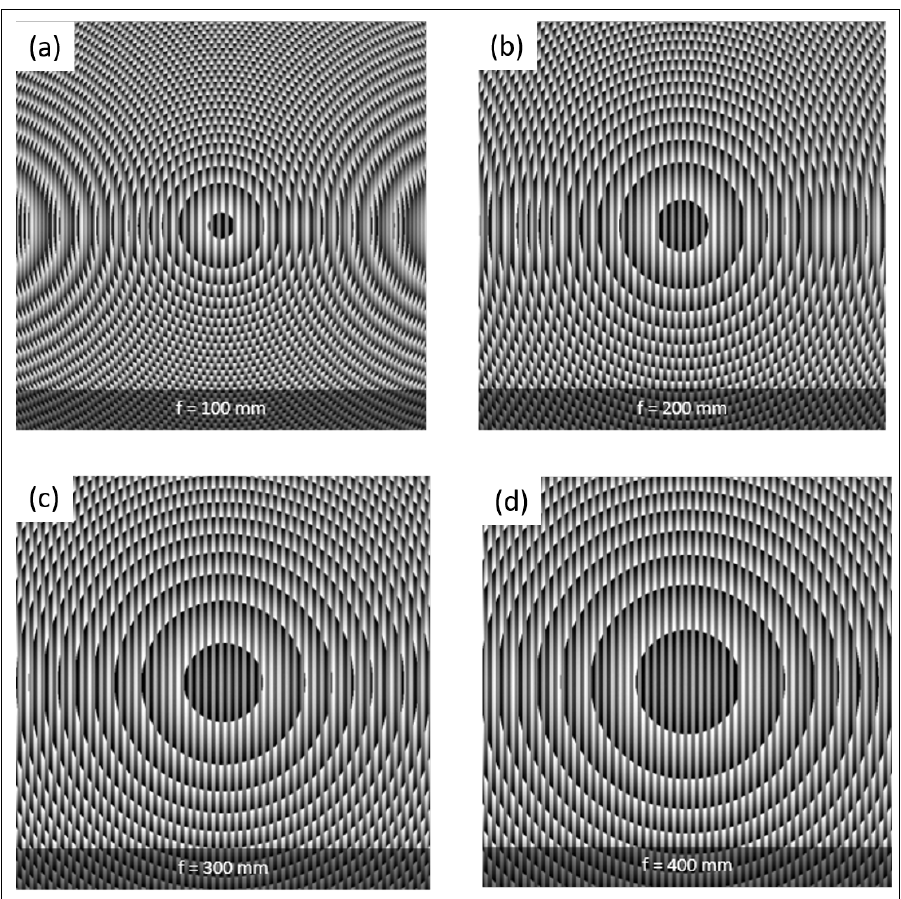
Figure 1. Phase distributions of four diffractive structures with different focal lengths: